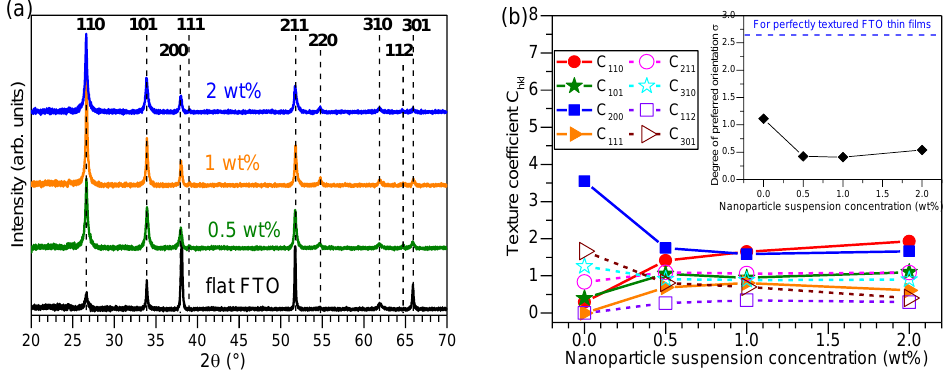
Figure 4. ( a ) X-ray diffraction (XRD) θ-2θ patterns of Al 2 O 3 nanocomposites and respective reference flat FTO. The dashed lines mark the diffraction peaks of FTO (PDF: SnO 2 00-041-1445); ( b ) Texture coefficient C hkl plotted against nanoparticle suspension concentration for Al 2 O 3 -FTO nanocomposites. The inset shows the evolution of the degree of preferred orientation σ.